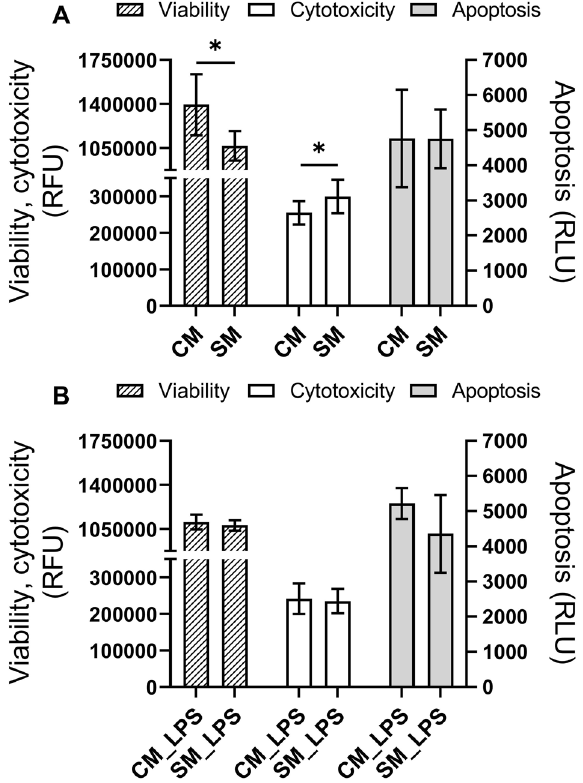
Figure 2. Viability, cytotoxicity and apoptosis of LESC in response to conditioned medium from ADSC (CM) in standard condition and in induced inflammation (LPS groups). The activity of the dead-cell proteases (viability and cytotoxicity) and the activity of caspase 3/7 (apoptosis) are shown as relative fluorescence units or the relative luminescence units. ( A ) CM compared to SM group. ( B ) CM_LPS compared to SM_LPS group. SM standard medium. The bars represent the means ± standard deviation (SD). T-test, *p <